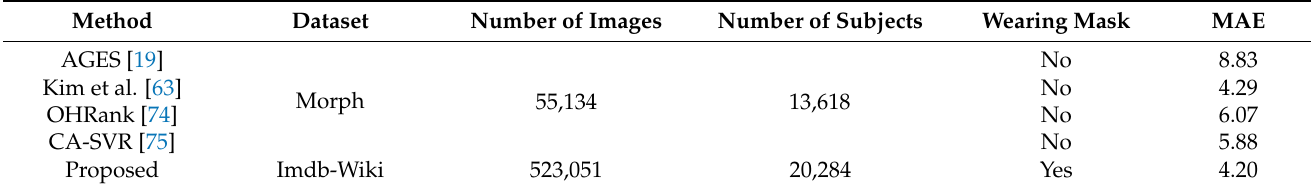
Table 5. Performance comparison with existing prominent facial age estimation methods.